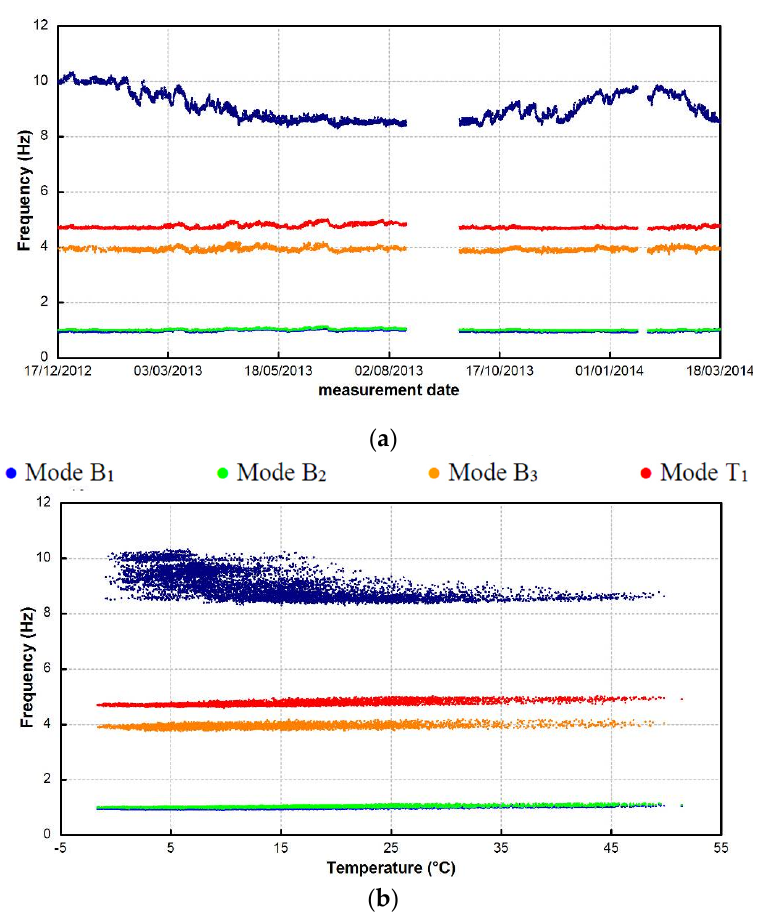
Figure 9. Natural frequencies, automatically identified from 17/12/2012 to 17/03/2014, plotted ( a ) vs. time and ( b ) vs. temperature. Table 1. Statistics of the natural frequencies identified (SSI ‐ Cov) from 17/12/2012 to 17/03/2014.